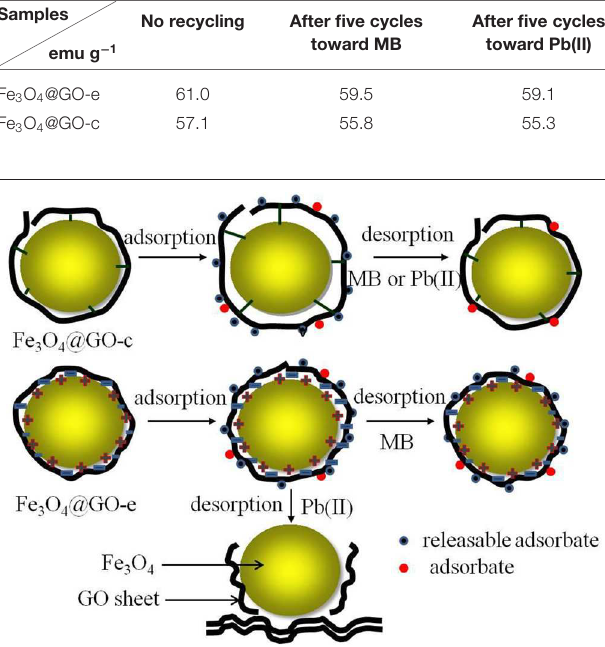
FIGURE 6 | Sketch illustrating the structure evolution of Fe 3 O 4 @GO-c and Fe 3 O 4